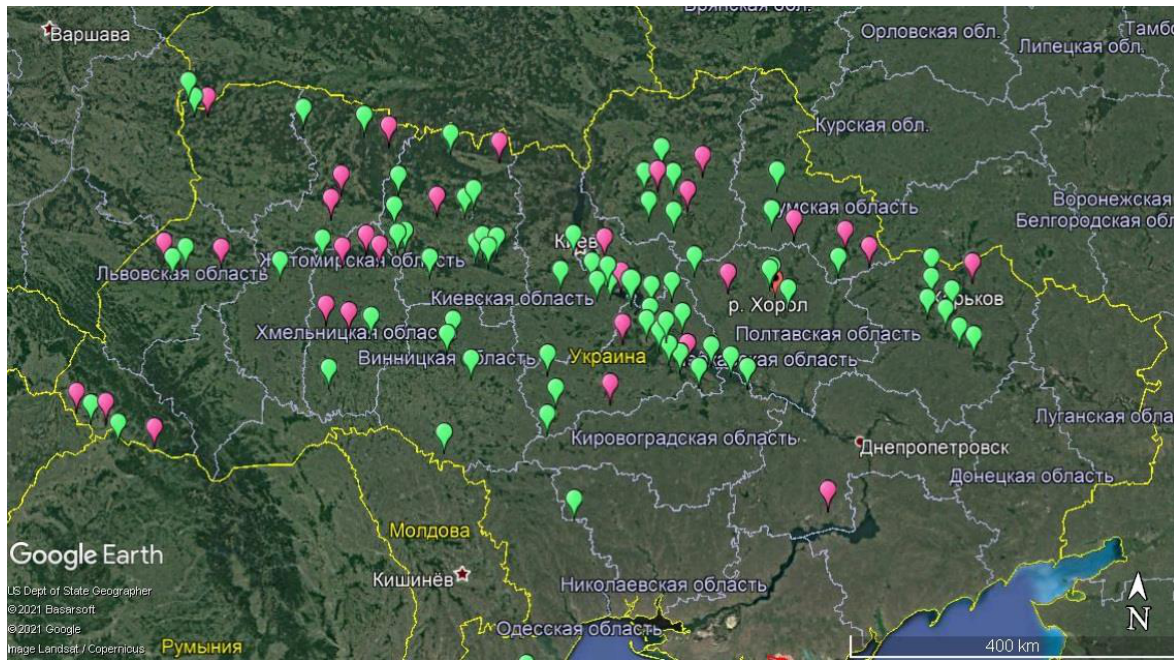
Fig. 1. A distribution map of the localities of annual herb vegetation in Ukraine (pink colour marks localities of the class Isoëto-Nanojuncetea, green colour – of the class